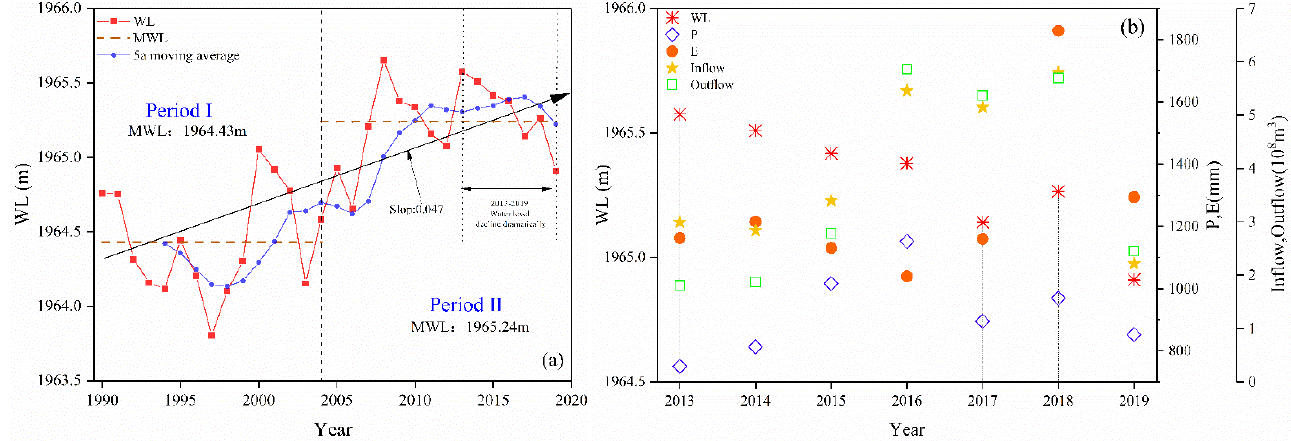
Figure 7. Interannual variations of water level during 1990–2019 ( a ) and hydrometeorological changes ( b ) in 2013–2019.